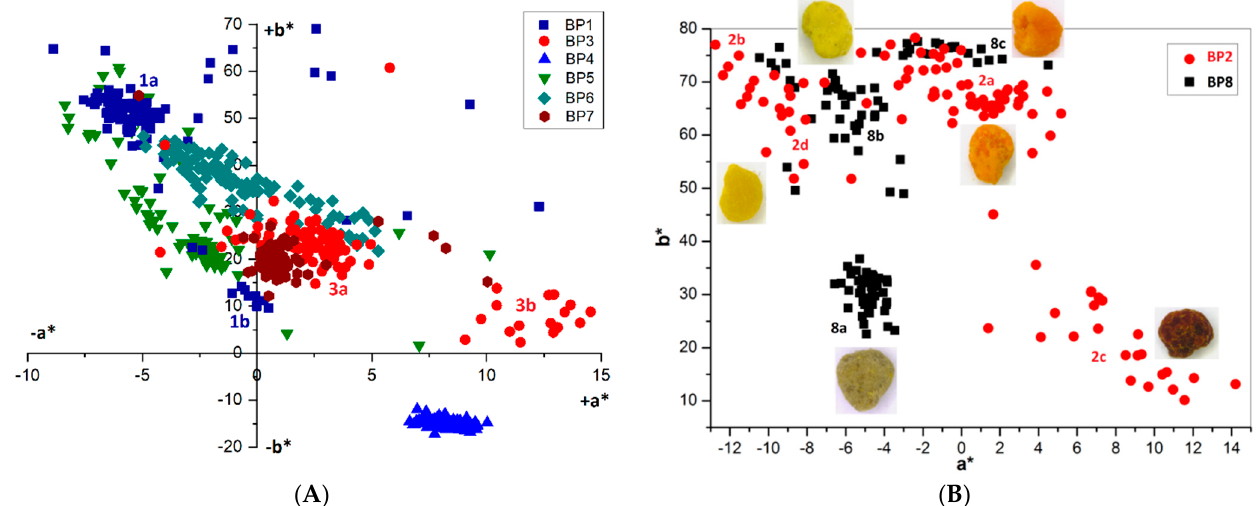
Figure 5. Chromatic diagram {a*; b*} for bee pollen loads: ( A ) BP1 , 3 – 7 (100 loads per sample); ( B ) BP2 and BP8 and images of loads corresponding to the individual fractions.